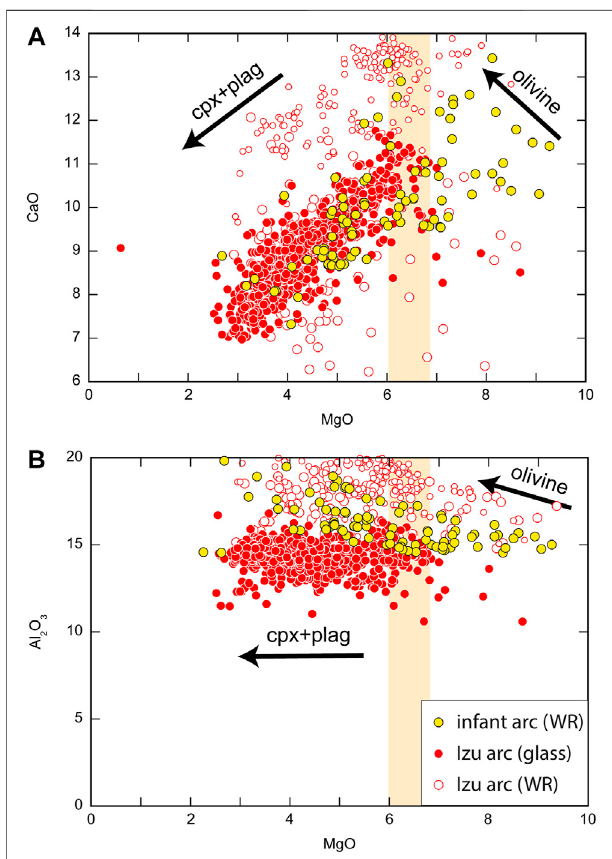
FIGURE3| Fractionationtrends. (A) CaO(wt%),and (B) Al 2 O 3 (wt%)vs. MgO (wt%) diagrams. The kink in MgO ~6 – 7 wt% in the basaltic lavas marks the onset of plagioclase (plag) and clinopyroxene (cpx) fractionation, implying thatbasaltswithMgO ≥ 6 – 7 wt%arelikelytohaveonlycrystallizedolivine along their liquid line of descent, so they may have retained their primary composition. WR, whole rock